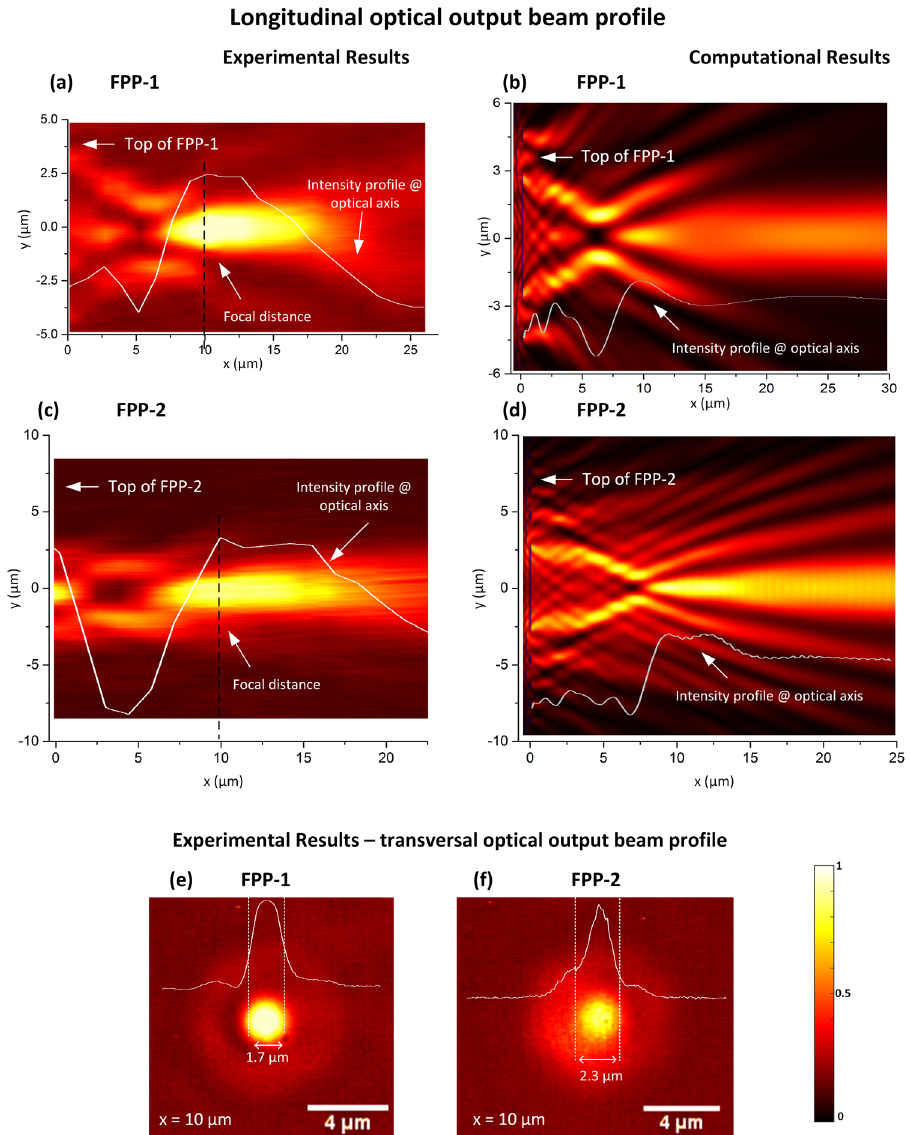
Figure 6. Longitudinal optical output beam profile for FPP-1: ( a ) experimental; ( b ) computational. Longitudinal optical output beam profile for FPP-2: ( c ) experimental; ( d ) computational. Transversal optical output beam profile at the main focal point: ( e ) FPP-1; ( f ) FPP-2.